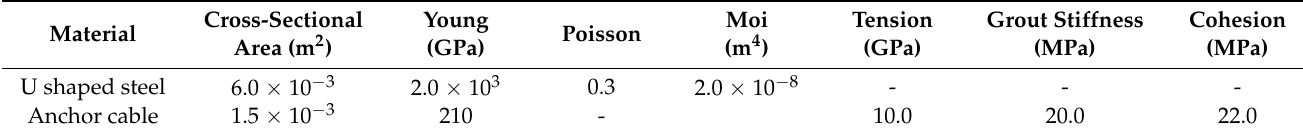
Table 2. Micro-parameters for the support